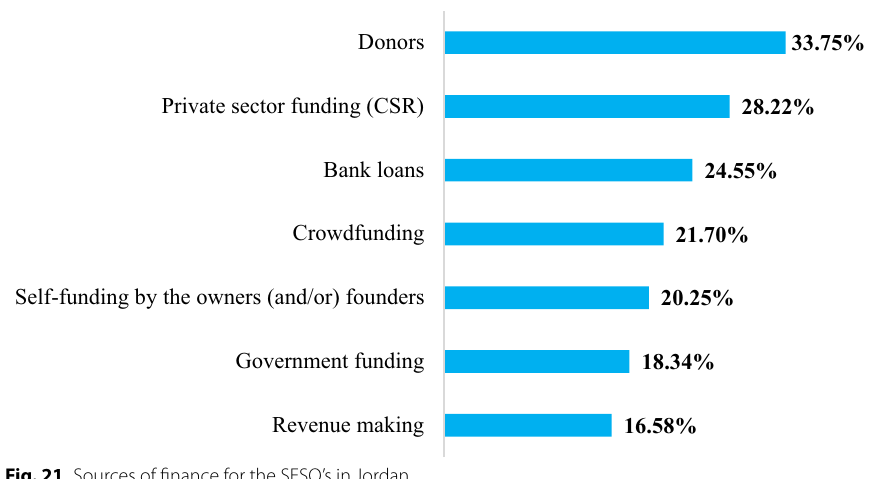
Fig. 21 Sources of finance for the SESO’s in